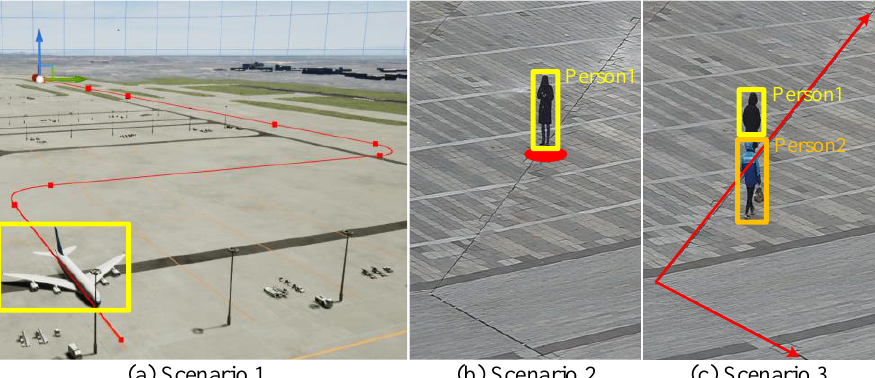
Figure 5. Experimental scenarios. ( a ) In Scenario 1, the simulated airplane taxed along the taxiway (red). ( b ) In Scenario 2, the target Person 1 stood still at a fix point (red). ( c ) In Scenario 3, the target Person 1 walked back and forth along a polyline (red) where some occlusions occurred between pedestrians. The yellow and orange boxes represent the object detection bounding boxes.